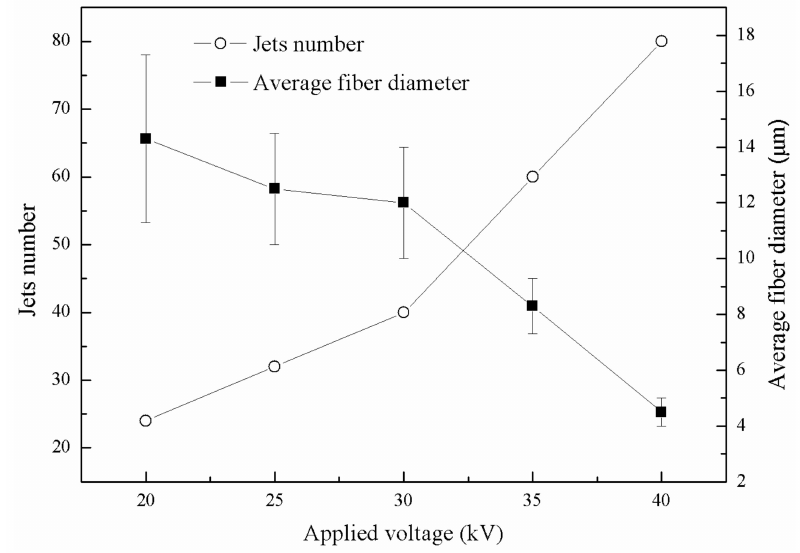
Figure 8. Jets number and average fiber diameter at di ff erent applied